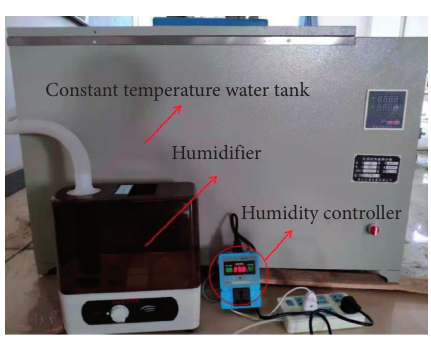
Figure 2: Temperature- and humidity-controlled box. Table 2: Some parameters of the constant temperature and hu- midity box.